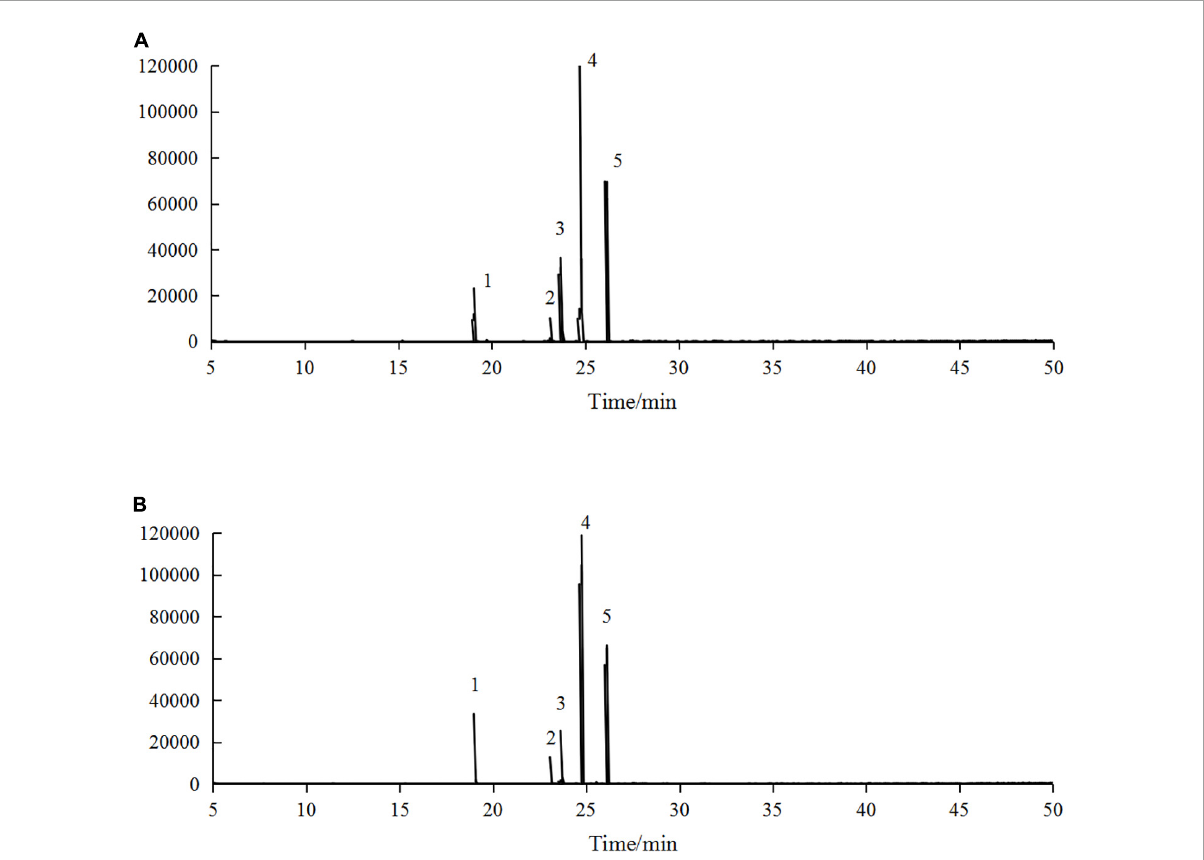
FIGURE5 Gas chromatography-mass spectrometry (GC-MS) profiles of panel (A) H. rhamnoides seed oil and (B) microencapsulated H. rhamnoides seed oil: 1. palmitic acid methyl ester, 2. stearic acid methyl ester, 3. oleic acid methyl ester, 4. linoleic acid methyl ester, 5. α -linolenic acid methyl